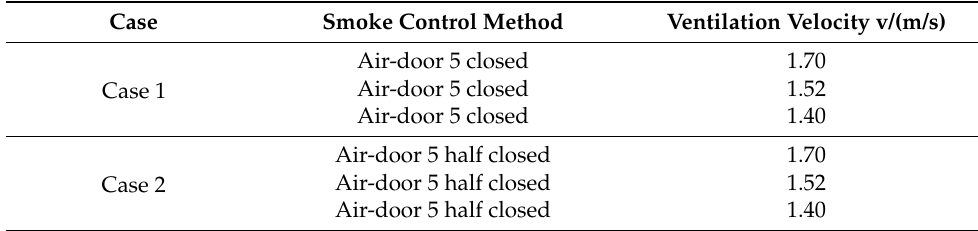
Table 1. Ventilation network with parallel branches scheme setting. Table 2. Ventilation network with a diagonal branch scheme setting.